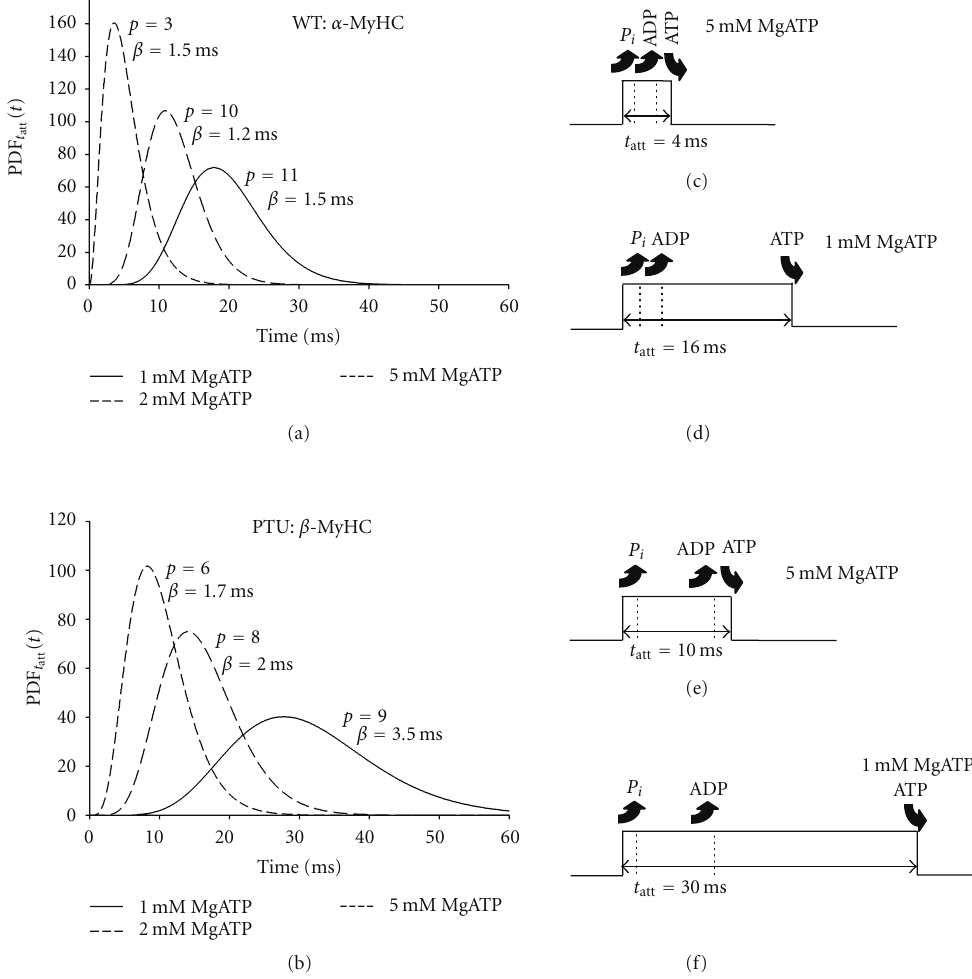
Figure 8: Predicted gamma distributed PDF t ( t ) for the two myosin isoforms under varying MgATP conditions at 37 ◦ C. (a) The parameter att values estimated for the α -MyHC demonstrate an increasing shape parameter and prolonged t att as MgATP was reduced. The resulting ( t ) looks more Gaussian in shape rather than exponential as MgATP was reduced. This would be consistent with a longer rigor state PDF t att prior to MgATP binding and detachment of the myosin crossbridge. (b) The distributions for β -MyHC represent longer t att compared to α -MyHC. Again, a longer rigor state would arise with lower MgATP. (c, d) In the α -MyHC at 5mM MgATP, the release of P i , release of ADP, and binding of ATP occur in relatively quick succession. The time periods that represent the P i and ADP states, however, would not be a ff ected by MgATP availability. With the reduction in MgATP concentration, the rigor state would be prolonged as detected in the viscoelastic mechanics. (e, f). In the β -MyHC, the ADP state is longer than that in the α -MyHC and the rigor state is more dramatically prolonged with decreasing MgATP compared to α